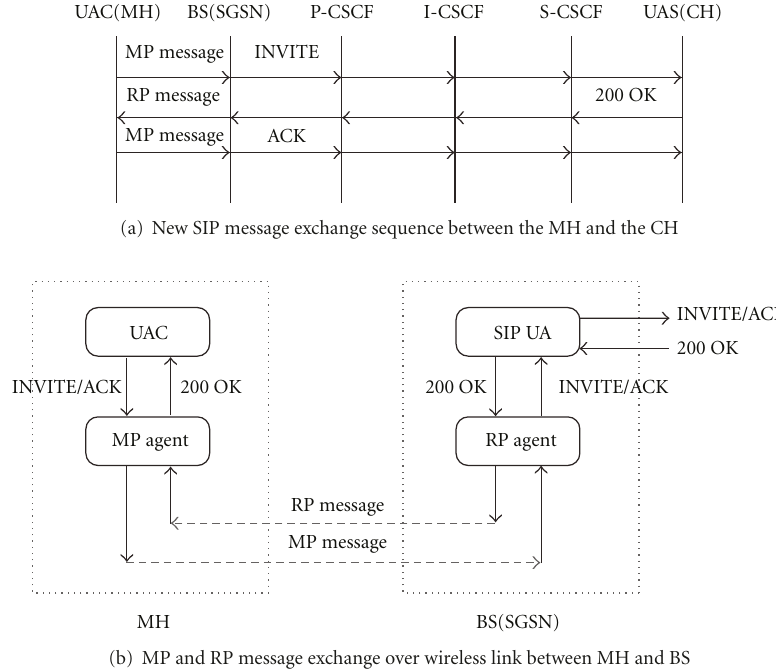
Figure 3: Message exchange for the reestablishment of the connection via new BS right after inter-subnet handover.